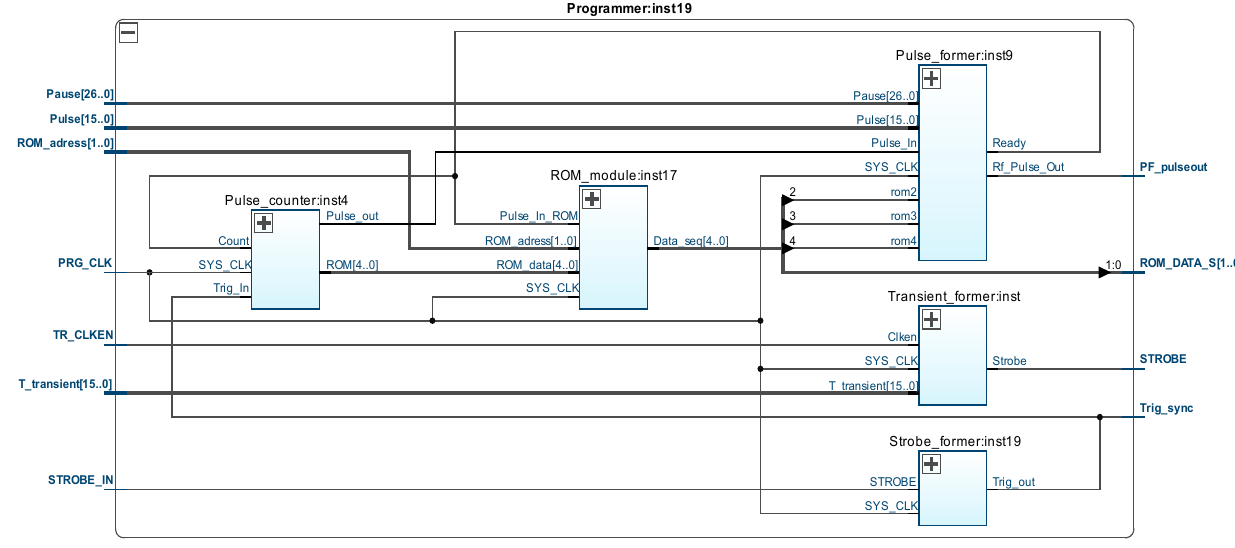
Figure 4. Configuration structure of pulse sequence programmer based on FPGA.